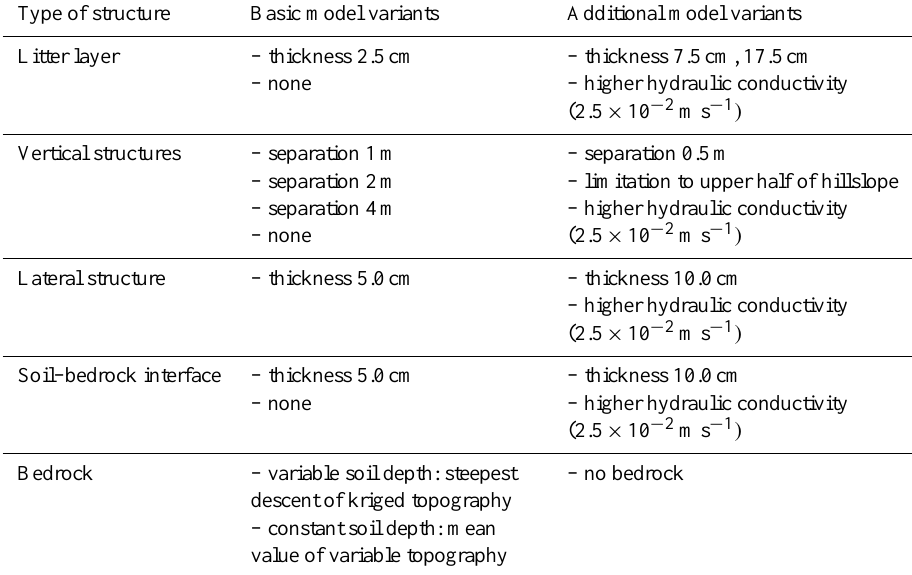
Table 1. Overview on model set-up variants: five different types of structures have been considered in different realisations for generating the structural set-ups; all 64 combinations of the “basic model variants”, plus selected modifications of these combinations given as “additional model variants”, were tested for simulation.